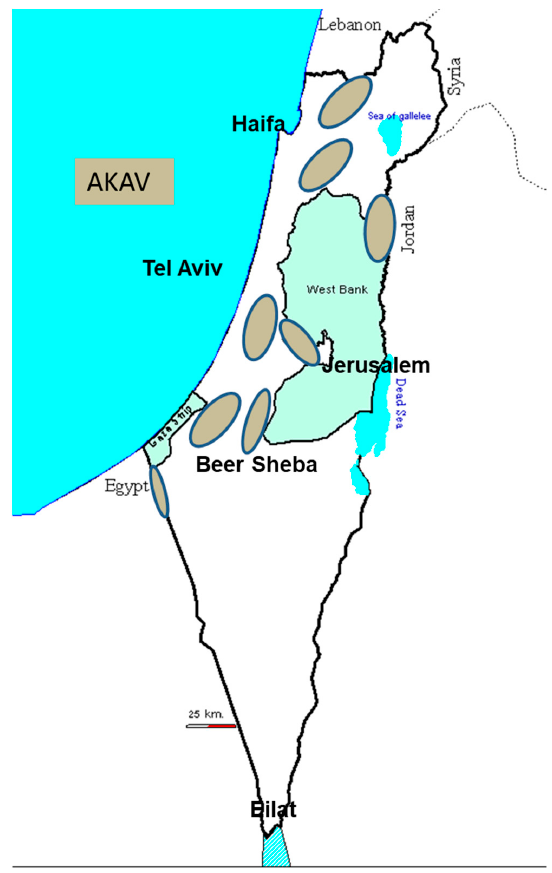
Figure 3. This figure portrays the arthrogryposis hydranencephaly syndrome reported in 2012 linked to Akabane virus (AKAV) infections in